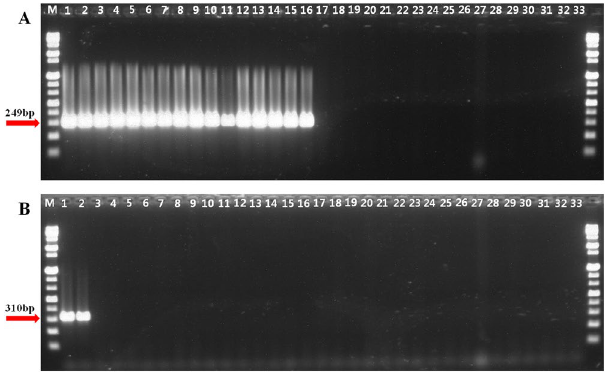
Figure 1. Specific PCR amplification of Bacillus velezensis ( A ) and B. subtilis subsp. subtilis ( B ) with the Bam249F/R and BS310F/R primer sets. ( A ) B. velezensis . Lane M is the size marker (1 kb DNA plus ladder; Gibco BRL). Lanes 1–16 are B. velezensis strains. Lanes 17–32 are strains of other Bacillus species, as listed in Table 2, and lane 33 is the negative control (distilled water). ( B ) B. subtilis subsp. subtilis . Lane M is the size marker (1 kb DNA plus ladder; Gibco BRL). Lanes 1–6 are B. subtilis strains. Lanes 7–32 are strains of other Bacillus species, as listed in Table 3 and lane 33 is the negative control (distilled water).